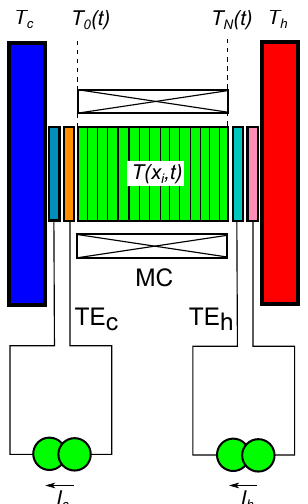
Figure 1. A “sandwich” formed by a magnetocaloric material (green block) and two thermoelectric or Peltier cells between a cold heat source at temperature T c and a hot heat sink at T h . The instanta- neous temperatures at different points of the MC material are indicated with vertical lines ( T ( x i , t ) , i = 0,1, . . . , N